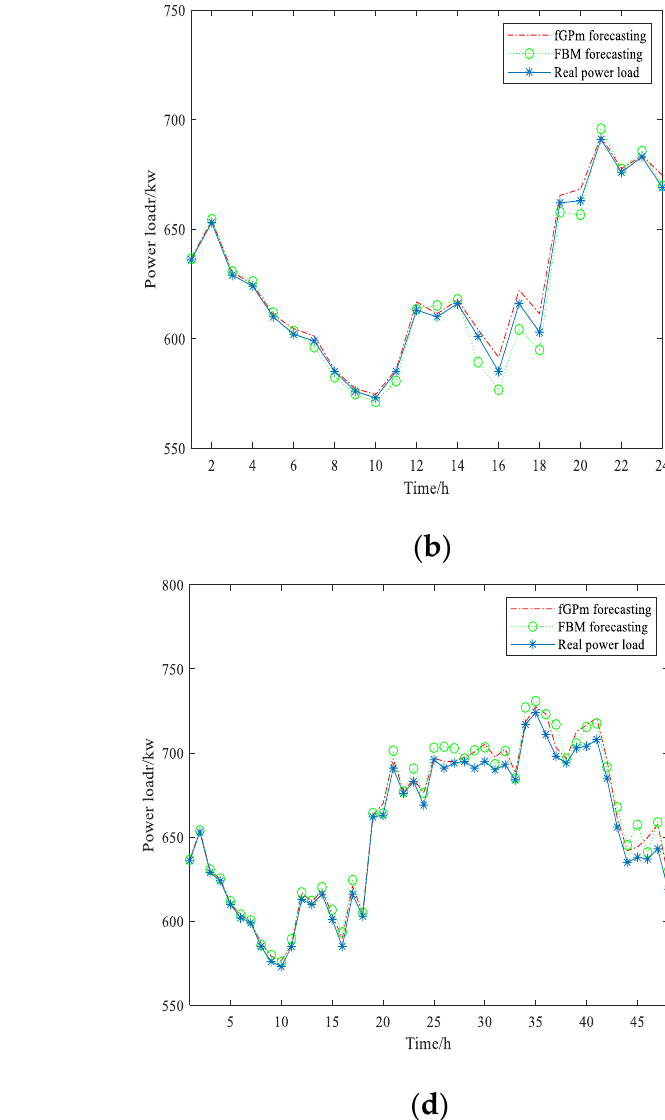
Figure 12. The 96-h power load of the actual working day of the fGPm forecast model and the